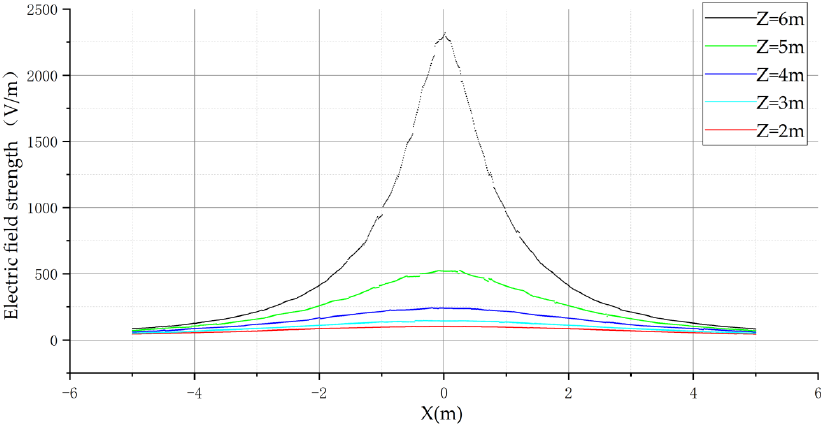
Figure 12. Electric field distribution in inverted triangular arrangement.